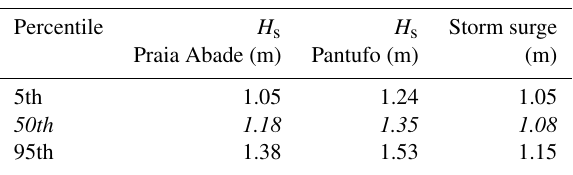
Table 2. Overview of H s and storm surge variations considered and corresponding to the 5th, 50th and 95th percentiles. The baseline value is